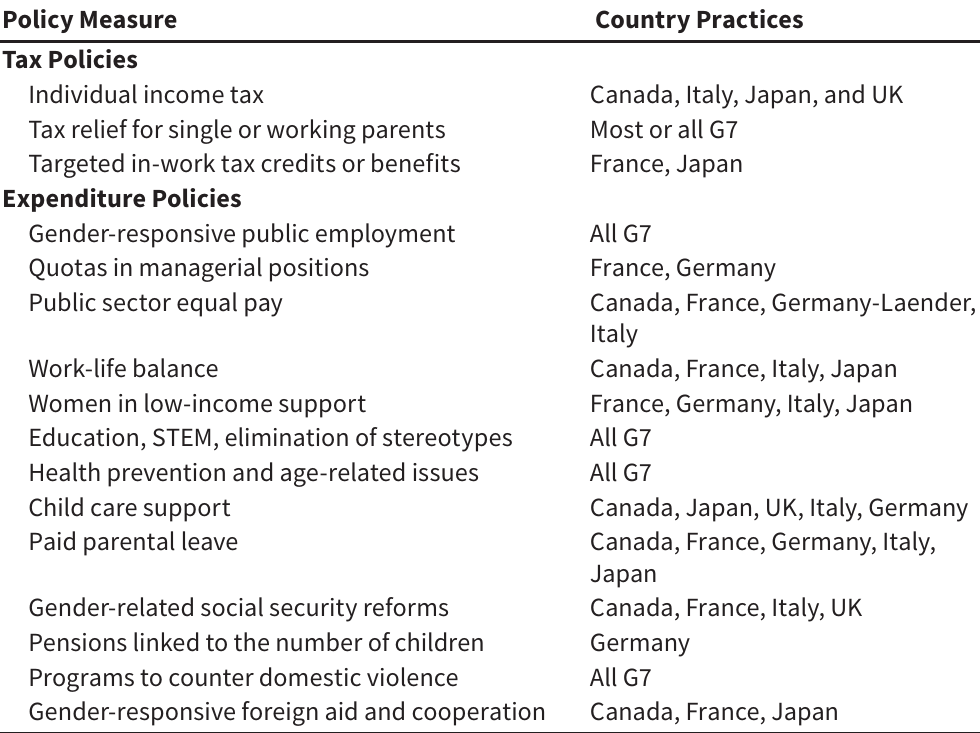
Table AII.1. Key Gender-Related Fiscal Policies Implemented by G7